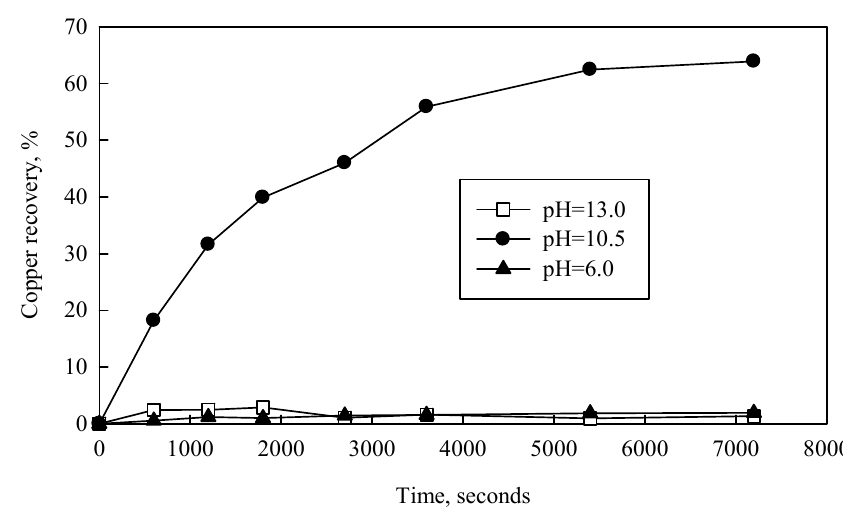
Figure 3. The effect of the solution pH on the dissolution of Cu 2 CO 3 (OH) 2 . Working conditions: NH 4 OH = 0.1 mol/dm 3 , temperature = 298 K, particle size = 5 μ m, stirring rate = 500 rpm and S/L ratio = 1:1000.